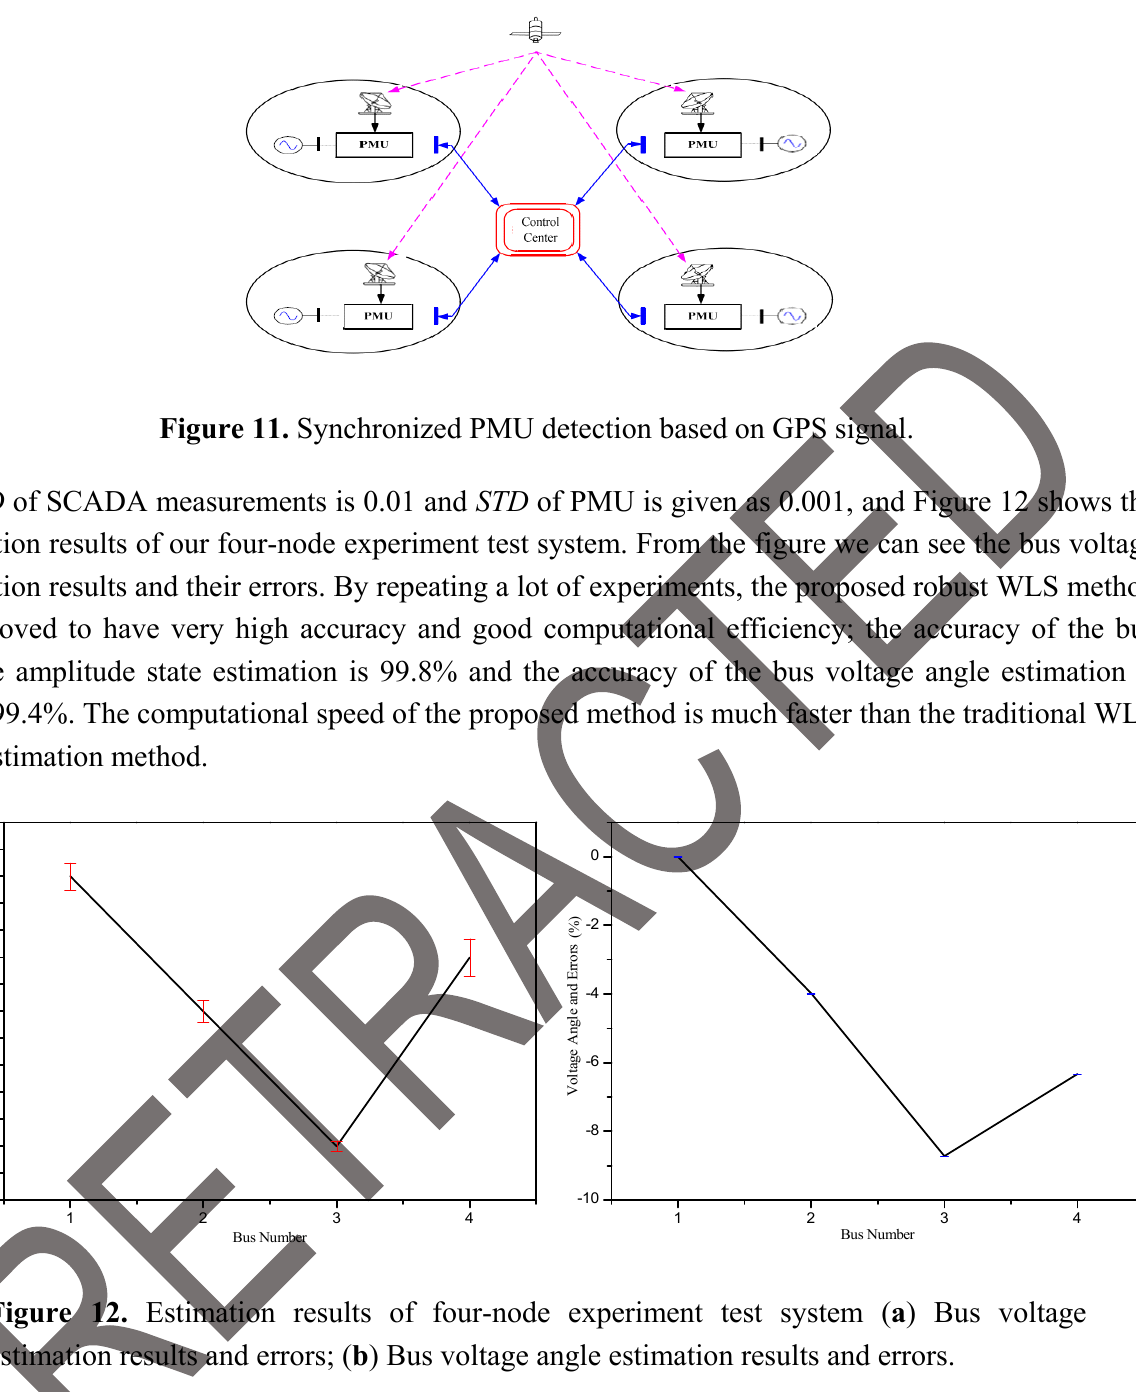
Figure 12. Estimation results of four-node experiment test system ( a ) Bus voltage estimation results and errors; ( b ) Bus voltage angle estimation results and